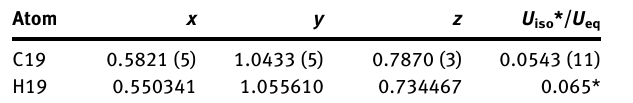
Table  : Fractional atomic coordinates and isotropic or equivalent isotropic displacement parameters (Å 